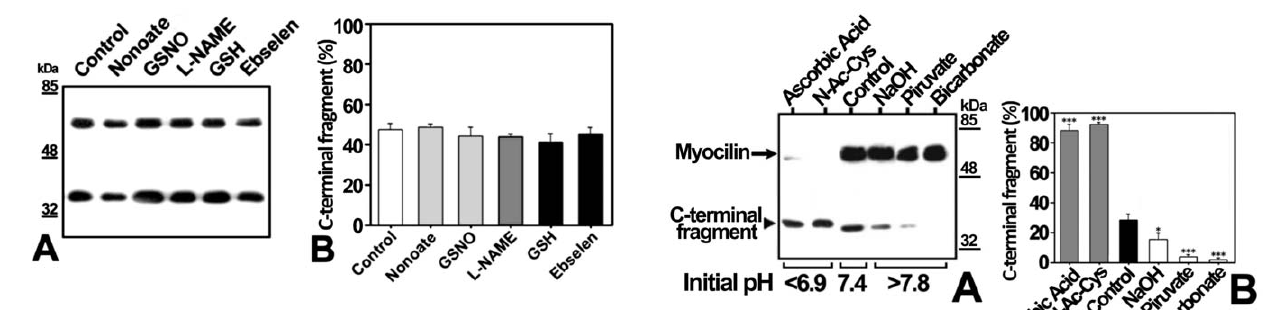
Figure 4. Effect of nitric oxide (NO) synthesis activators (Nonoate, GSNO) and inhibitors (L-NAME) and antioxidants agents (GSH, Ebselen) on myocilin proteolytic processing. (A) HEK-293T cells (500000 cells/plate) were transfected with a cDNA Figure 5. Effect of pH on myocilin proteolytic processing in